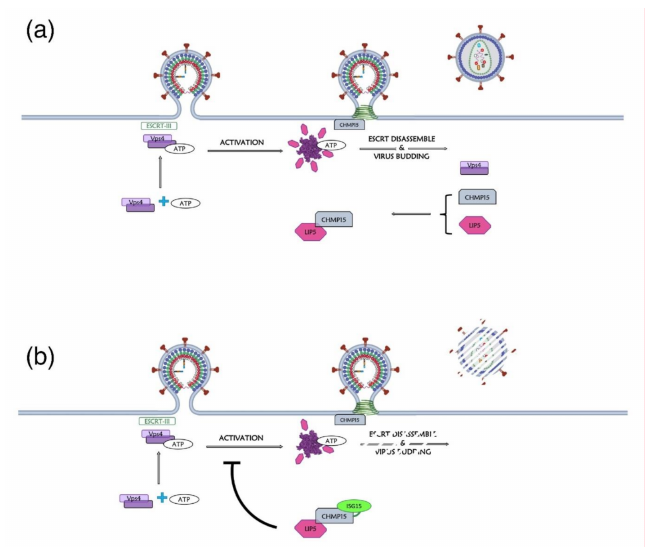
Figure 9. Model of the impact of ISG15 on Vps4 function during retroviral budding. ( a ) Normal assembly and budding phase during the retroviral cycle. Vps4 activity depends on its oligomeric state. In its dimeric form, Vps4 is cytosolic and inactive. During retrovirus assembly at PM, upon polymer- ization of the ESCRT-III complex with the p6 domain of HIV-1 Pr55 Gag , ATP-bound Vps4 is recruited at the PM. At this step, Vps4 interacts with the coactivator protein LIP5, which is bound to CHMP5, and achieves its double hexameric-ring structure. Then, ATP hydrolysis by the Vps4-LIP5 oligomer releases the ESCRT-III complexes from PM and the dissociation of the ESCRT complex coincides with the membrane fission event that releases retrovirus particles. ( b ) ISG15 inhibits the budding phase. When CHMP5 is ISGylated, this prevents the interaction between Vps4 and LIP5 by excluding LIP5. In the absence of the Vps4-LIP5 complex, the ESCRT-III complex remains trapped at the PM and the viral release is thus impaired (adapted from